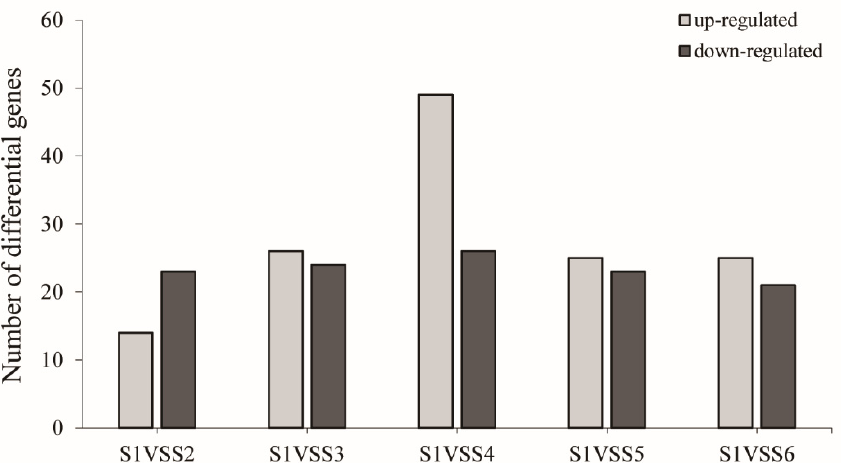
Figure 12. The number of differential genes upregulated and downregulated at 5 time